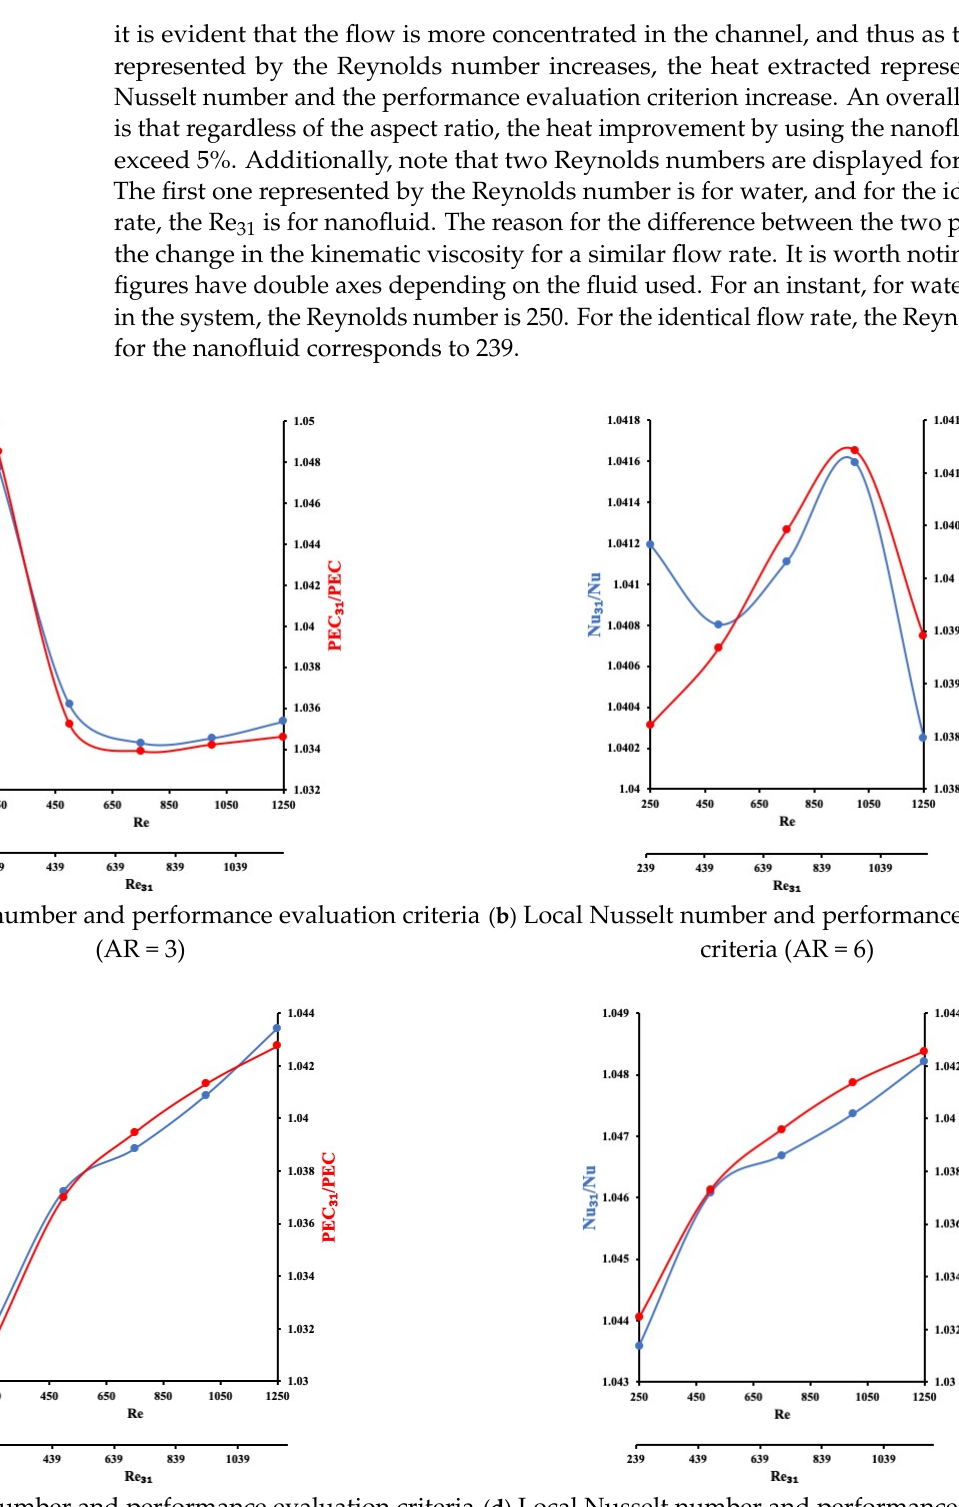
Figure 6. The ratio of the local Nusselt number and performance criterion between nanofluid and water (dp = 31 nm.